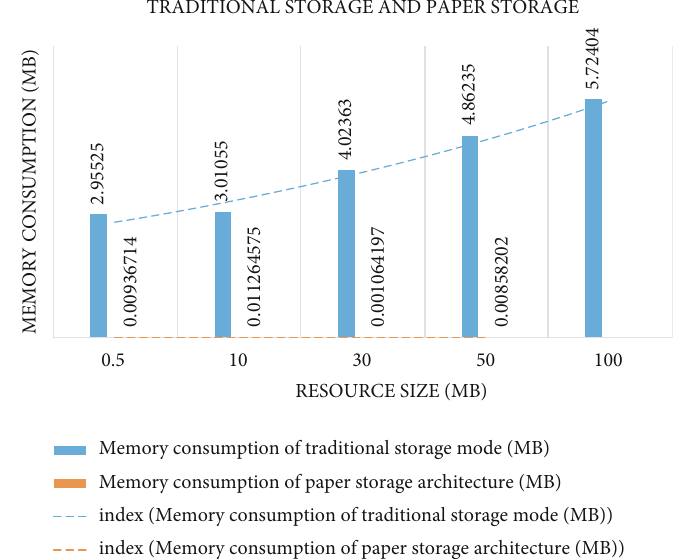
Figure 12: Memory consumption comparison between the traditional storage mode and the paper storage